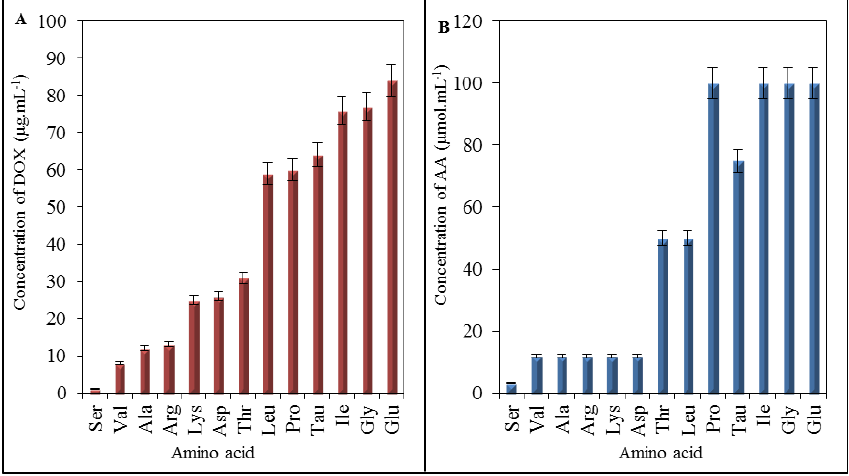
Figure 6. ( A ) Expression of DOX influence on amino acids via breaking points representing the lowest concentration of DOX showing a noticeable effect on amino acids. Results were obtained using IELC with postcolumn derivatization; ( B ) Expression of the effect of amino acids concentrations on DOX spectra carried out on UV/VIS spectrophotometry. There are shown amino acids concentrations, at which DOX